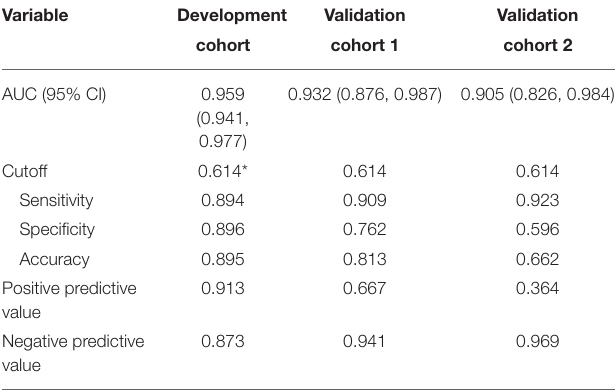
TABLE 2 | Performance of prediction